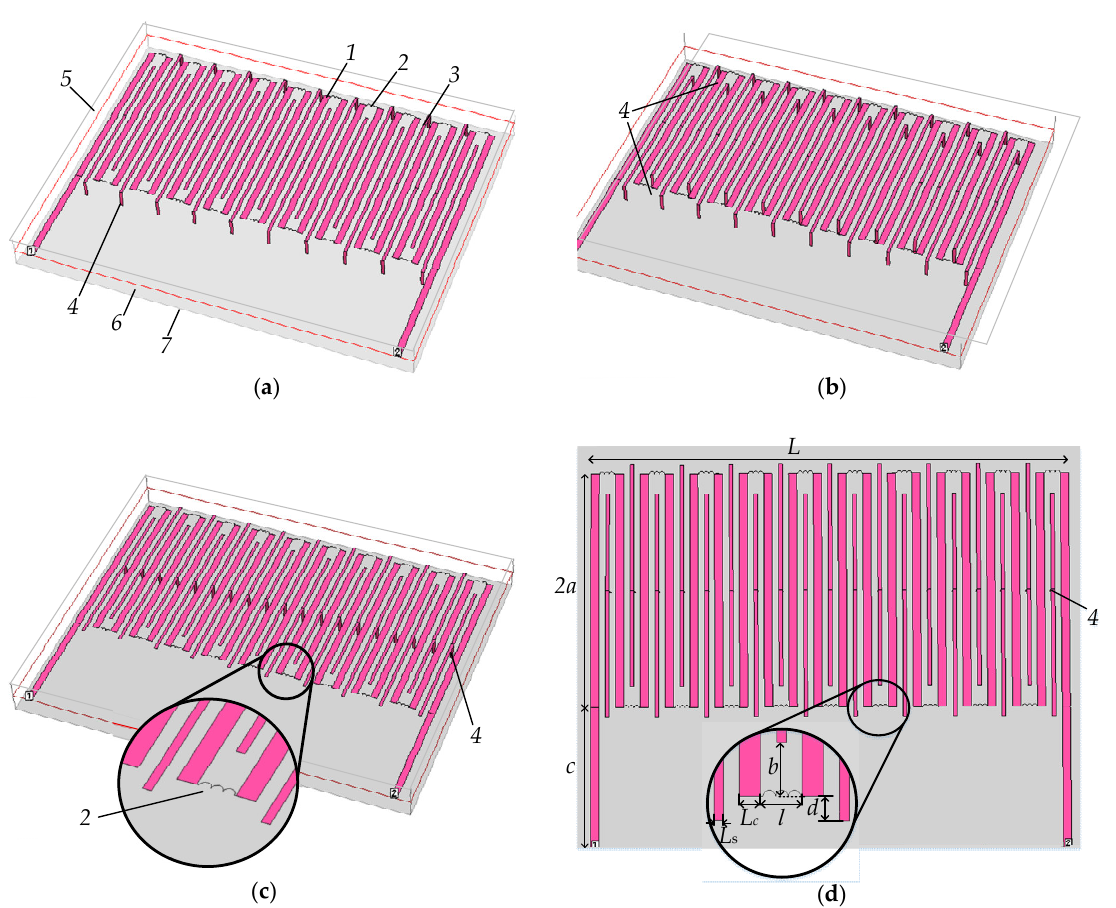
Figure 1. Three-dimensional views of the hybrid meander structure when additional shields are grounded in ( a ) one end, ( b ) both ends, ( c ) the middle and ( d ) the top view of hybrid meander structure with grounded in the middle additional shields when L = 20.28 mm, 2a = 10 mm, c = 6 mm, Lc = 0.35 mm, l = 0.7 mm, Ls = 0.15 mm, b = 0.9 mm, d = 0.4 mm, hs = 0.2 mm, and hc = 0.035 mm and where 1 is the meander-shape conductor, 2 is the lumped element, 3 is the additional shield, 4 is the grounded via, 5 is the air, 6 is the dielectric substrate, and 7 is the grounded external